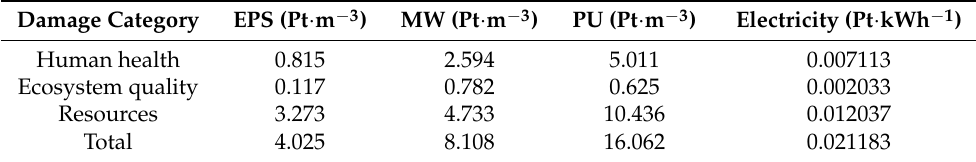
Table 3. The results of LCA analysis for insulation materials and electricity